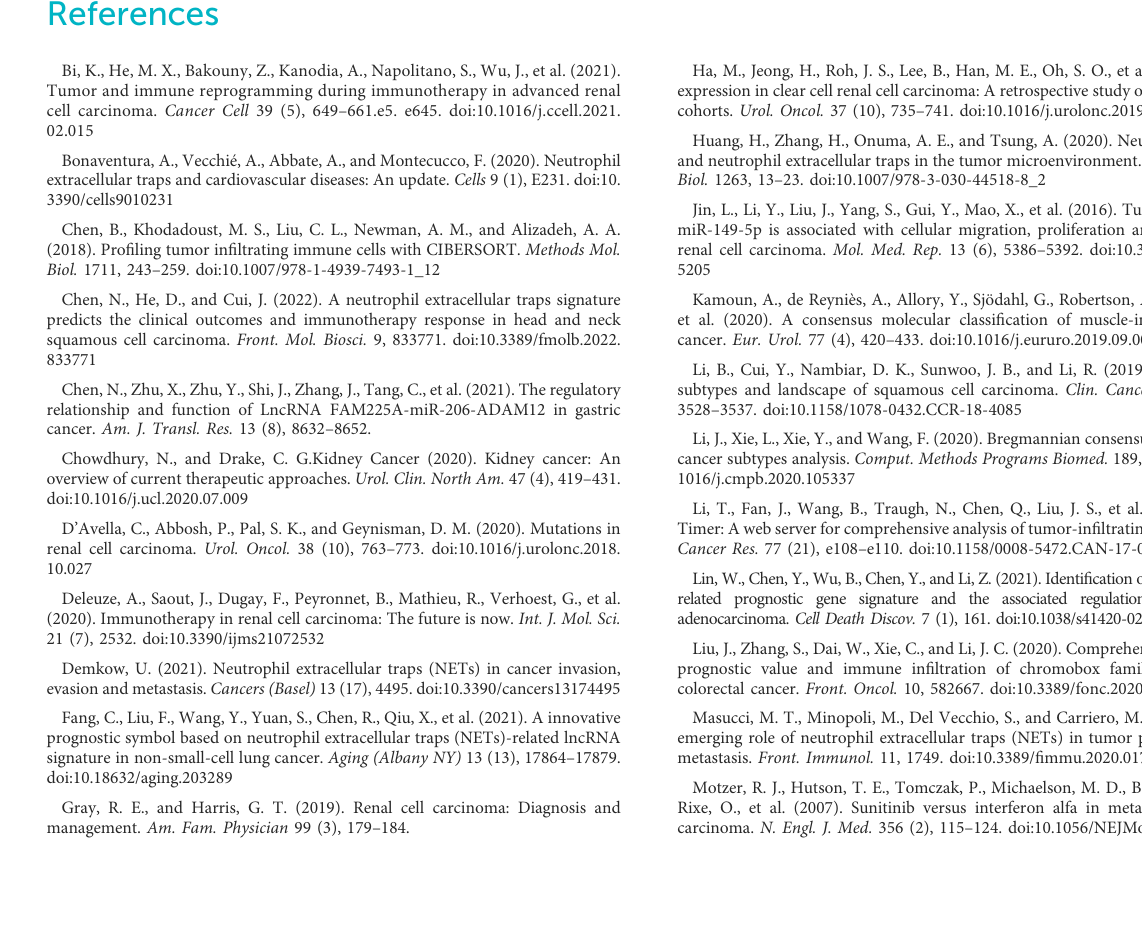
SUPPLEMENTARY FIGURE S1 FunctionalenrichmentanalysisofNET-relatedgenes.Theenricheditems in Gene Ontology (A) and Kyoto Encyclopedia of Genes and Genomes (B) analyses. SUPPLEMENTARY FIGURE S2 Prognostic signature in ccRCC based on NET-related genes in the ICGC dataset. (A) Riskscore distribution, patients ’ survival status, and gene expressionpro fi leoftheprognosticsignature. (B) ccRCCpatientsinthe high-risk group had a poor OS rate compared to that in the low-risk group. (C) AUCs of 1-year, 3-year, and 5-year ROC curves were 0.623, 0.654, and 0.638, respectively. NETs, neutrophil extracellular traps; ccRCC, clear cell renal cell carcinoma. SUPPLEMENTARY FIGURE S3 Correlation between the riskscore and immune cells in ccRCC. The correlation between the riskscore and the level of B cells (A) , CD4 + T cells (B) , CD8 + T cells (C) , neutrophils (D) , macrophages (E), and dendritic cells (F) in ccRCC. SUPPLEMENTARY FIGURE S4 CorrelationbetweenprognosticsignaturegenesandimmunecellsinccRCC. The correlation between immune cell in fi ltration and the level of DYSF (A) , MMP9 (B) , SLC22A4 (C) , SELP (D) , KCNJ15 (E) , and G0S2 (F) in